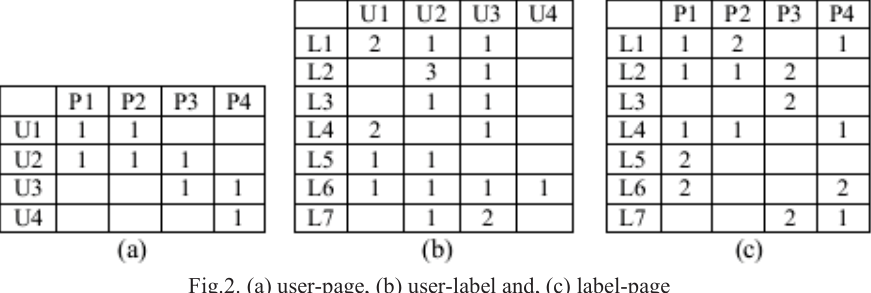
Fig.2. (a) user-page, (b) user-label and, (c) label-page